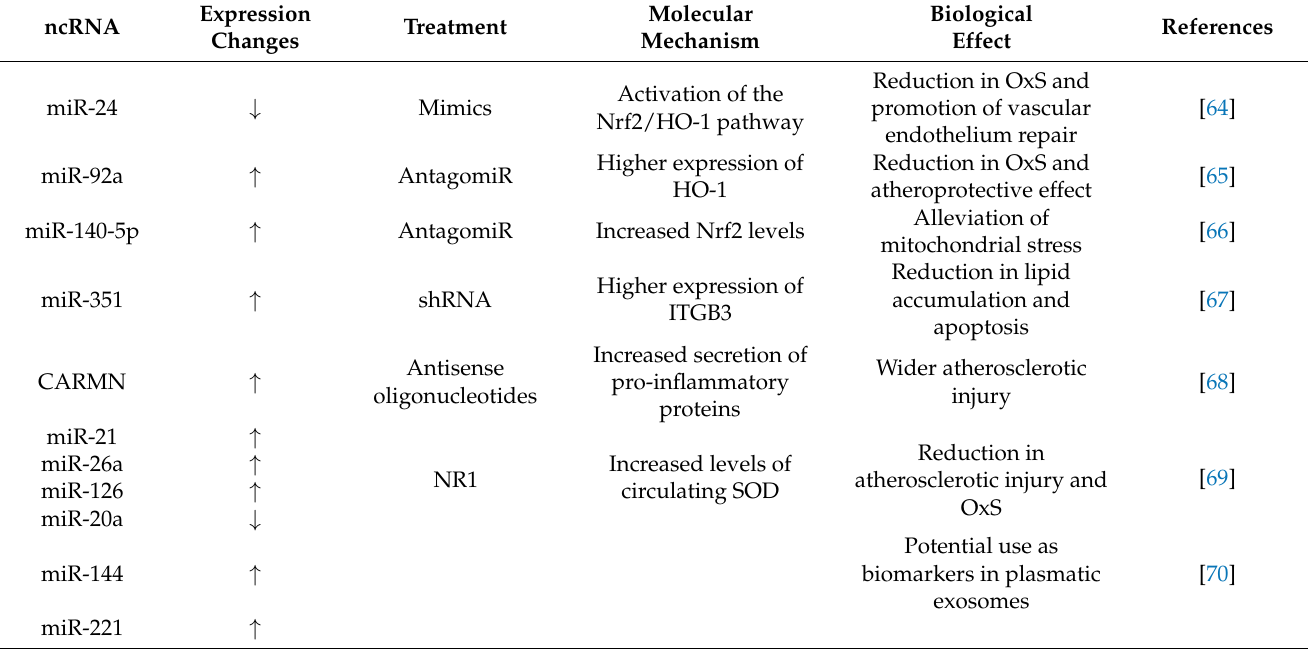
Table 1. Overview of ncRNA-based therapies for the treatment of oxidative-stress-driven injuries. ↑ up regulation, ↓ down